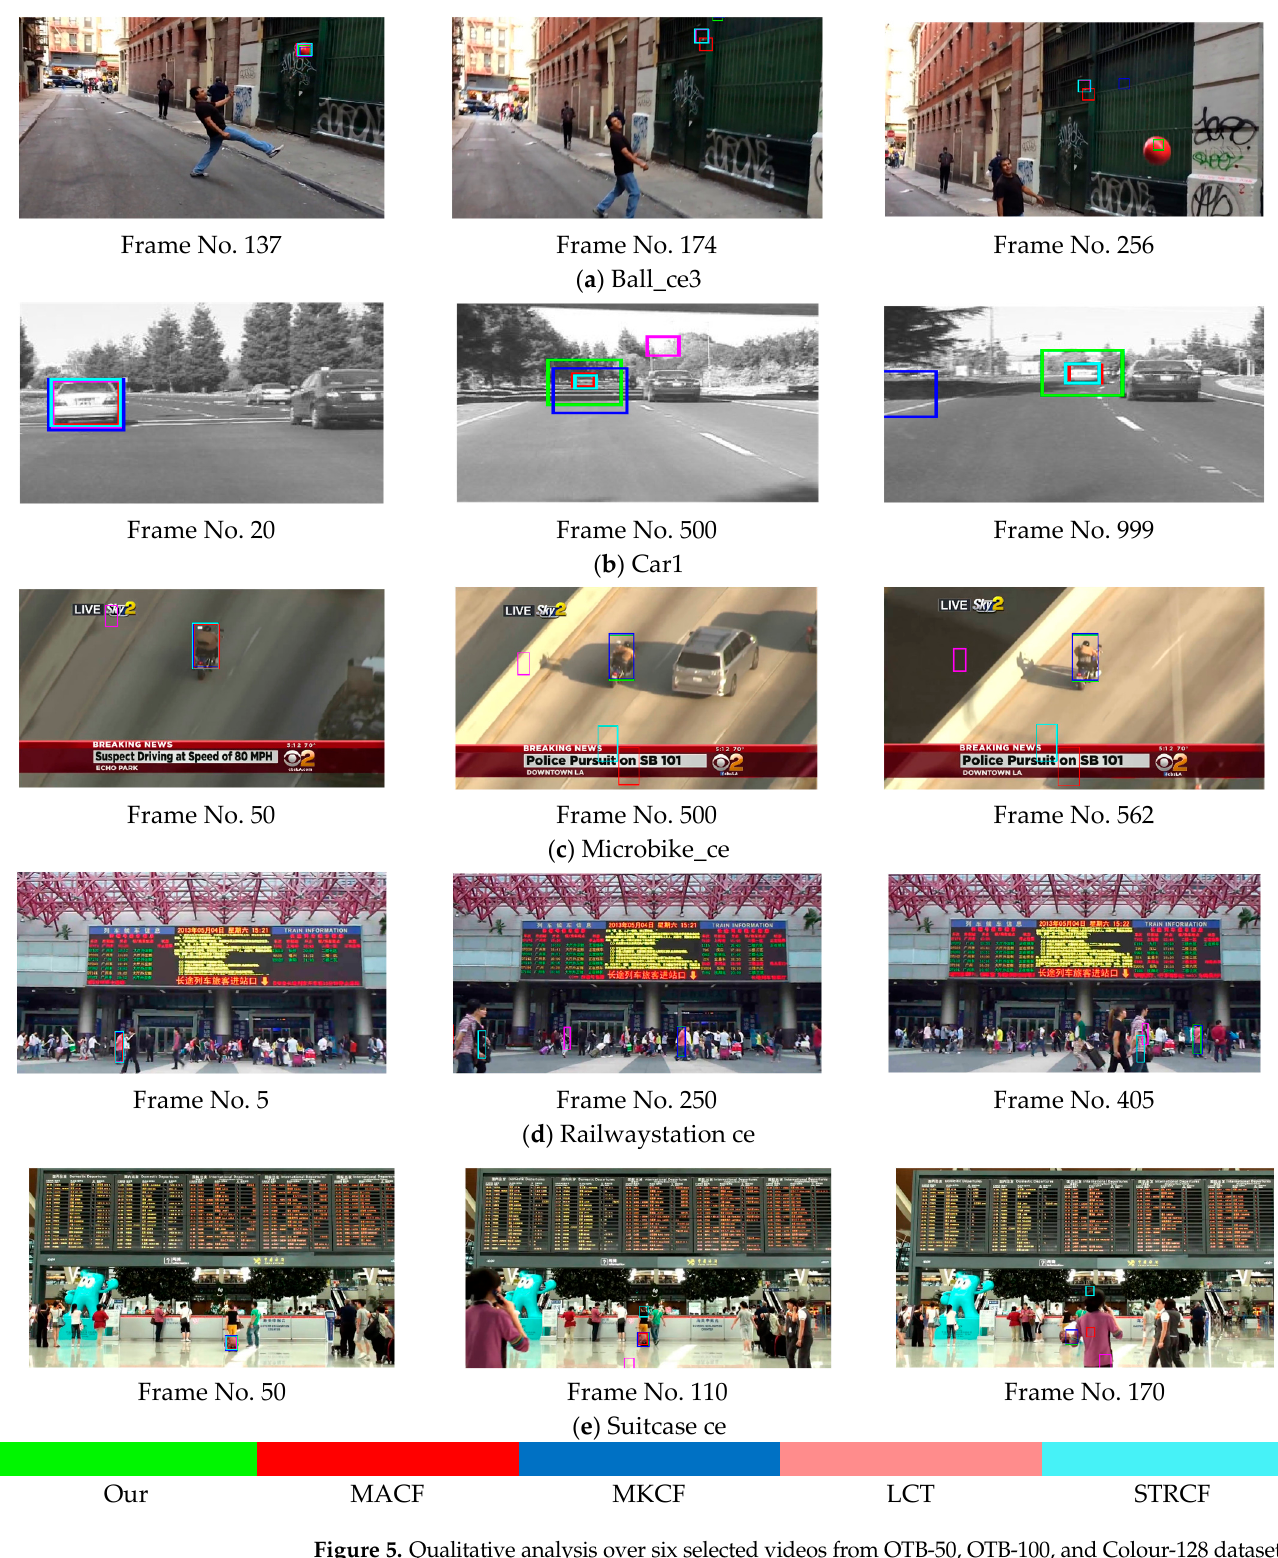
Figure 4. Quantitative analysis: comparison based on center location error. Six videos are selected